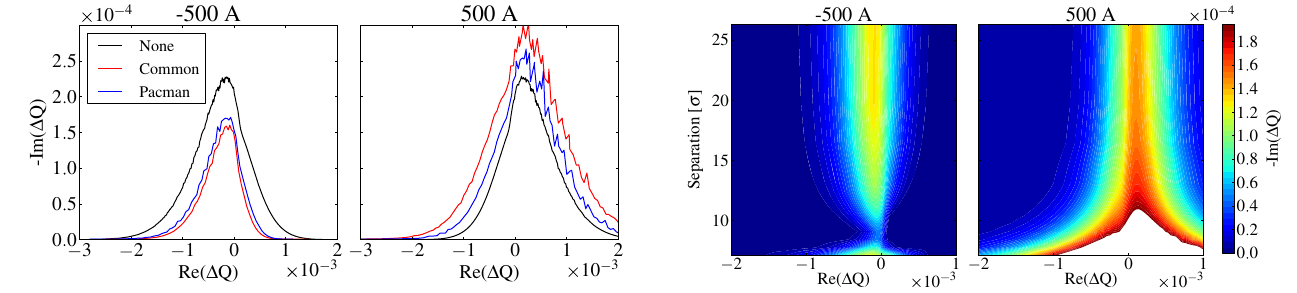
FIG. 8. Evolution of the most common bunch ’ s stability diagram as the normalized separation between the beams is reduced. Nominal LHC beams have a normalized separation of 10 σ at the end of the